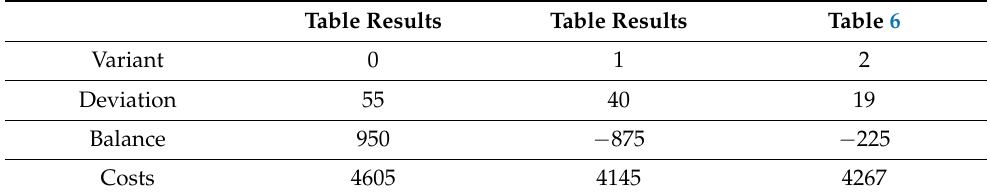
Table 8. An overview of the results of balanced